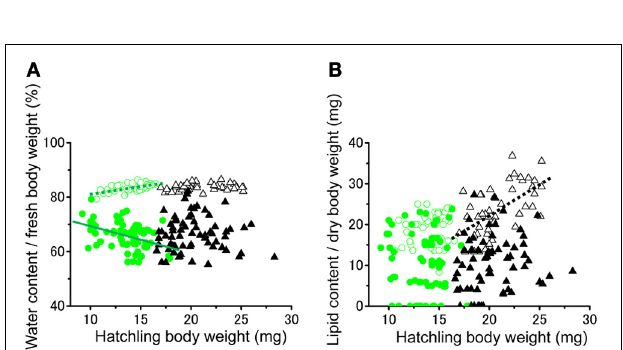
FIGURE 9 | Relationships between hatchling body weight at hatching and the ratios of percentage of water content / fresh body weight (A) or percentage of lipid content / dry body weight (B) of either solitarious ( (cid:2) , • ) or gregarious hatchlings ( (cid:2) , (cid:3) ) of Schistocerca gregaria pre- ( (cid:2) , (cid:2) ) or post- ( • , (cid:3) ) starvation. Regression lines are drawn when significant (green for the solitarious, black for gregarious, dotted line for pre-starvation, solid line for post-starvation). See Table 4 for statistical